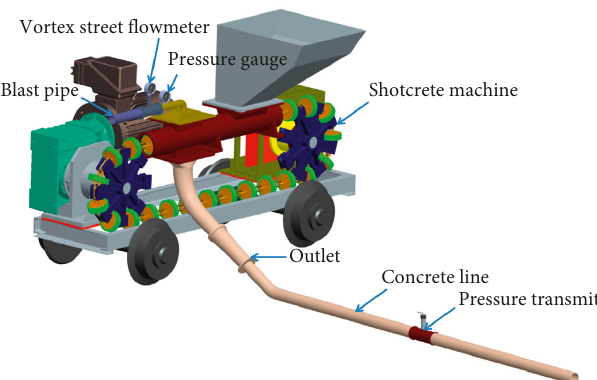
Figure 1: Structure of the PTS7 pushing chained shotcrete machine.